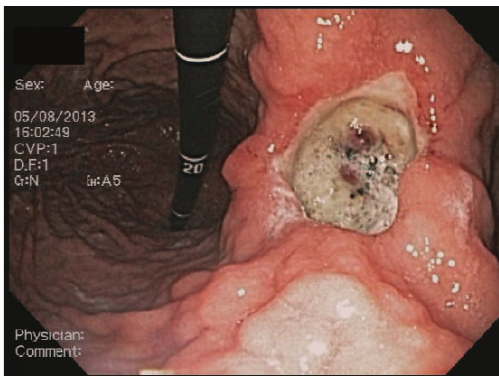
Figure 1: Two visible nonbleeding vessels in the ulcer base.